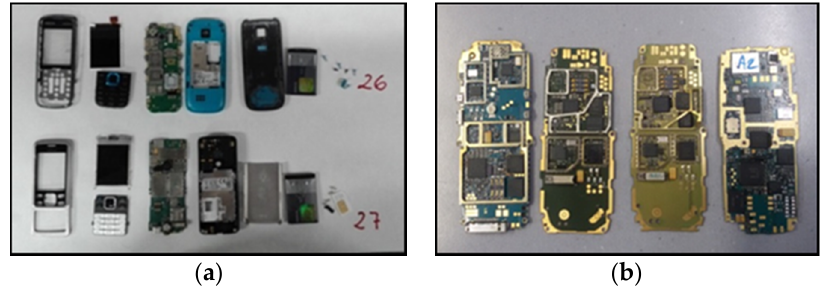
Figure 1. ( a ) Manual dismantling of mobile phones and ( b ) recovered